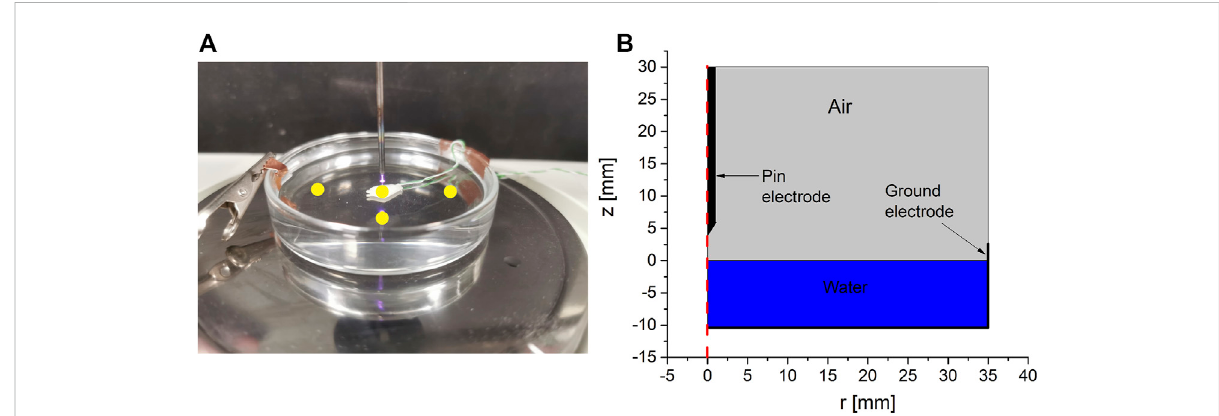
FIGURE 1 (A) A picture of the experimental setup used in this study and (B) the computational domain of the model representing the experimental setup. The yellow circles in panel a represent the points at which the temperature was measured. The point at the plasma contact point represents the thermocouple measurement at the bottom of the Petri